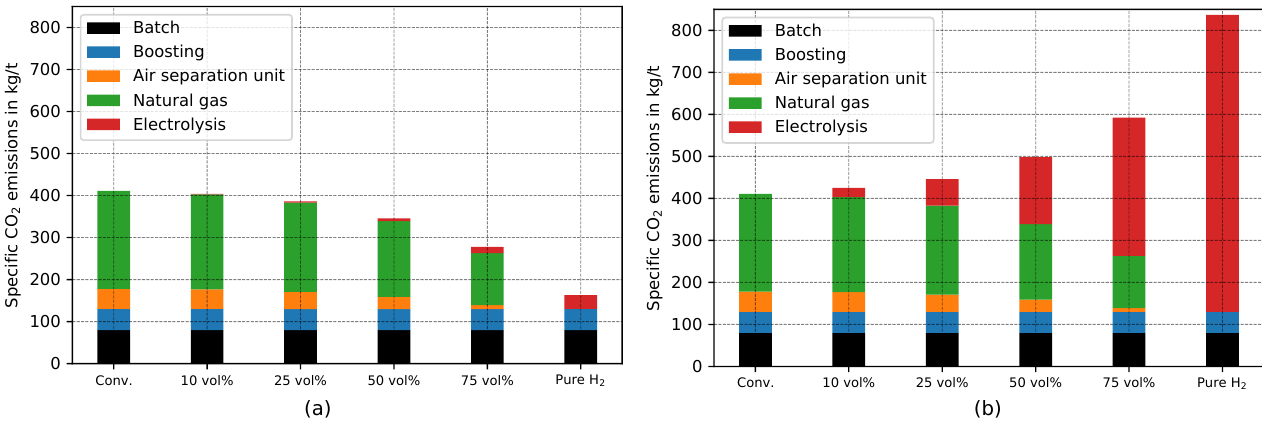
Figure 12. ( a ) Specific CO 2 emissions with the energy demand for electrolysis being covered by wind and PV (19 g CO 2 - eq./kWh). ( b ) Specific CO 2 emissions with the energy demand for electrolysis energy demand being covered by the current German energy mix (427 g CO 2 -eq./kWh